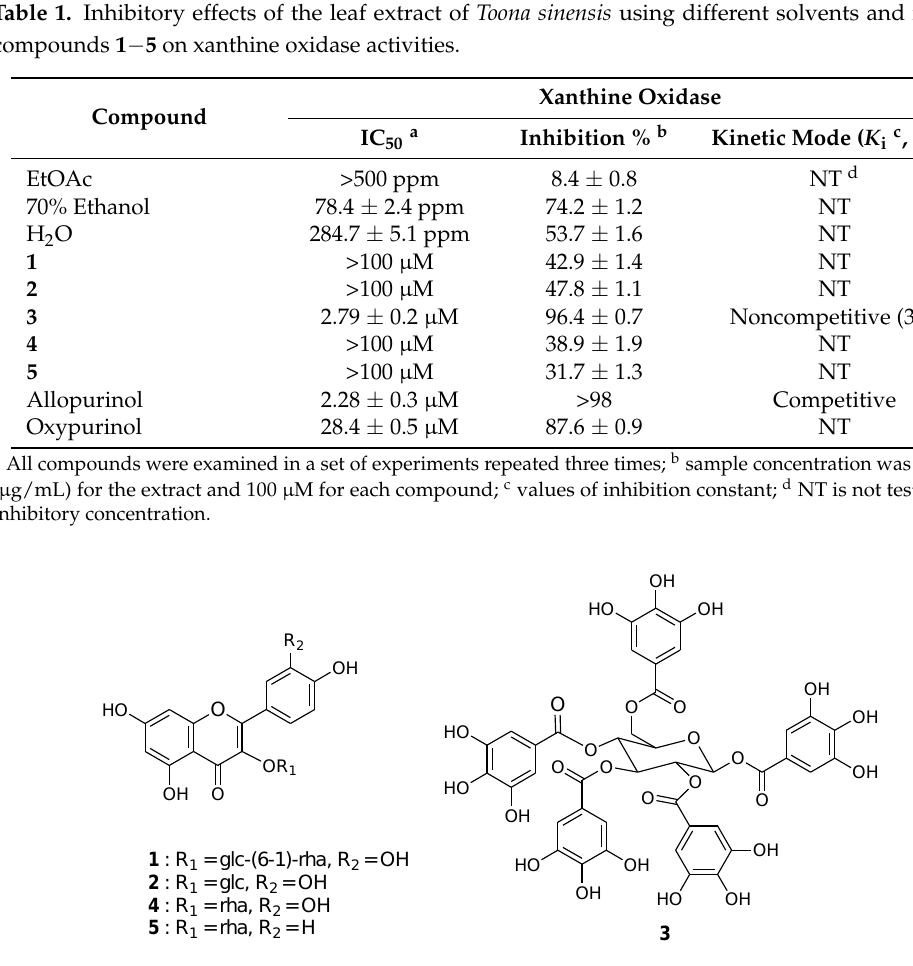
Figure 1. Chemical structures of isolated compounds ( 1 − 5 ) from the leaves of T. sinensis .